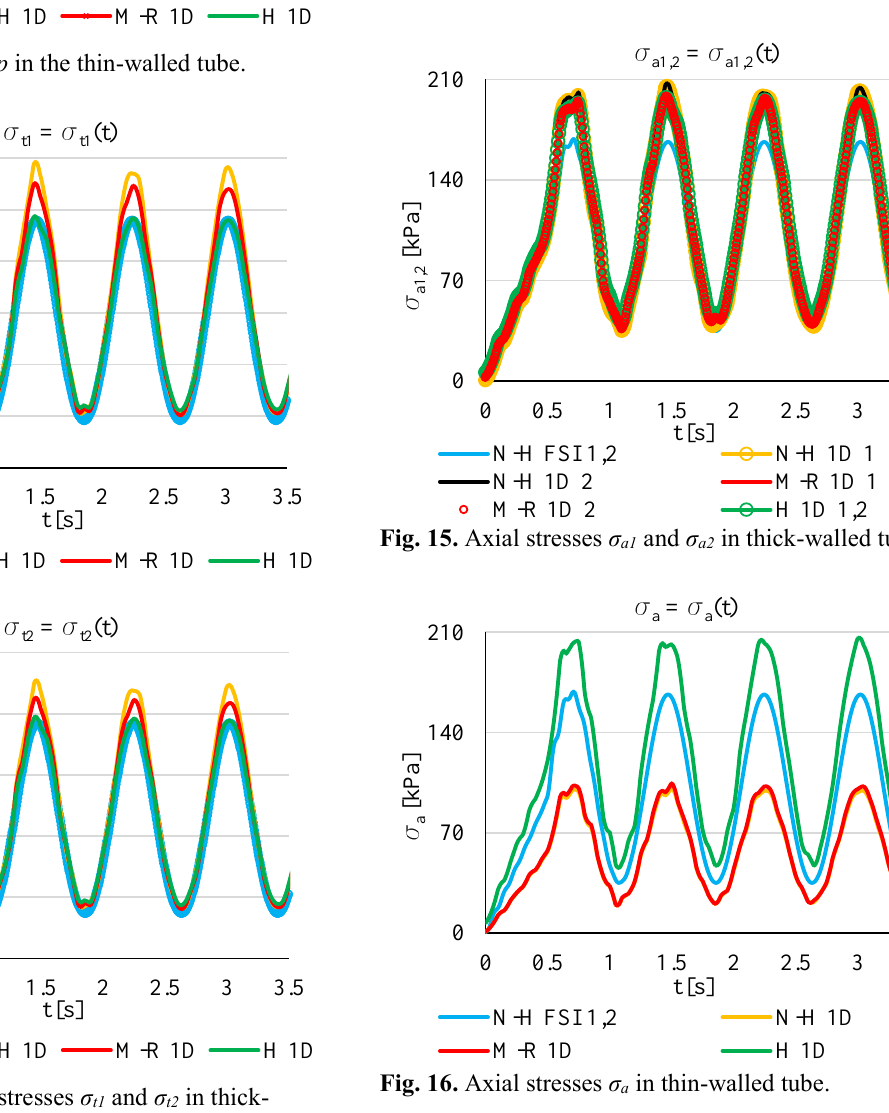
Fig. 14. Circumferential stresses σ t in thin-walled tube.